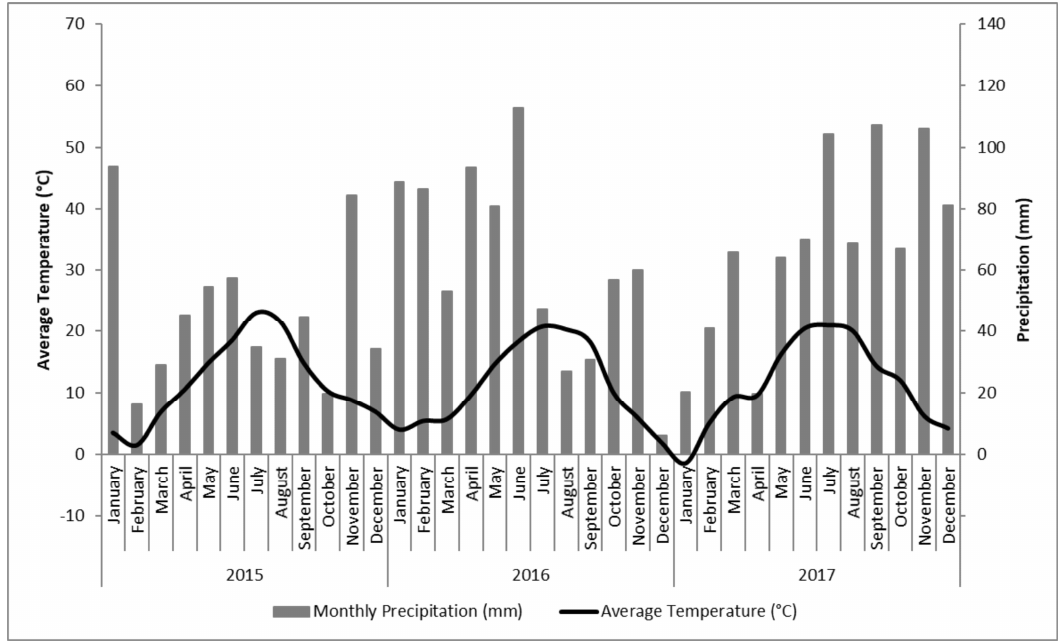
Figure 1. Average temperature (°C) and monthly sum of precipitation (mm) during the three experimental years 2015 to 2017.